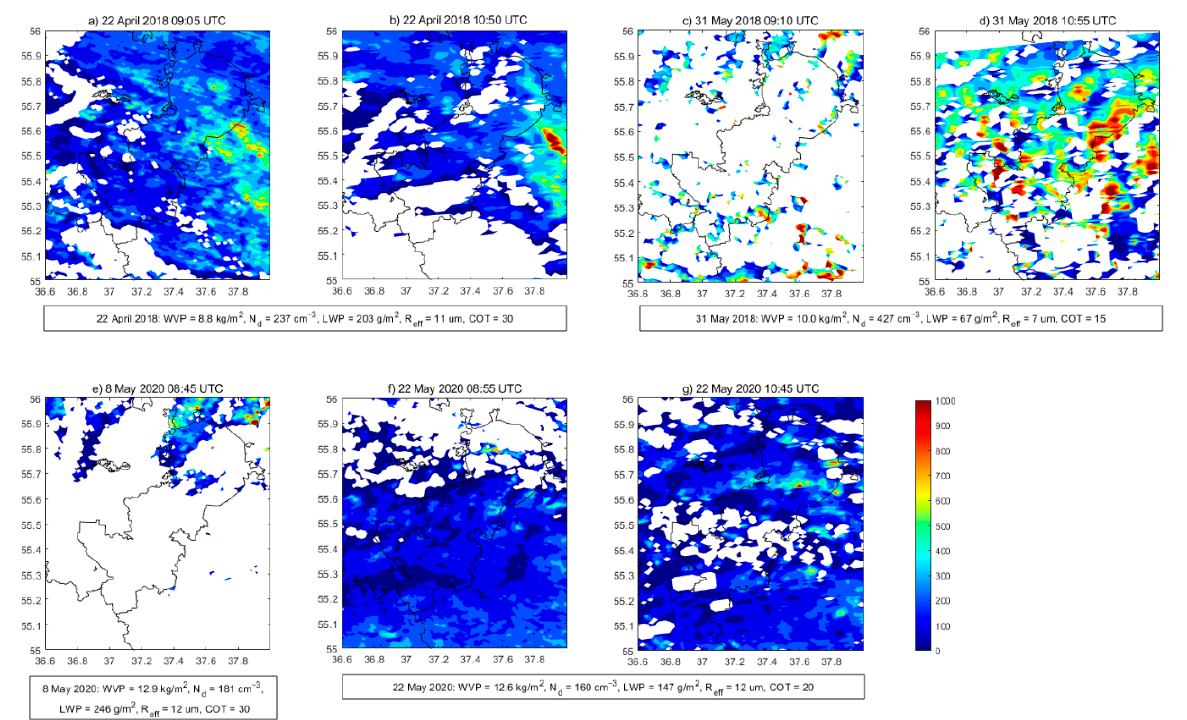
Figure 5. Spatial distribution of the droplet number concentration retrieved by method 2 for NWP sample. Each subfigure ( a – g ) describes an observational case sample.